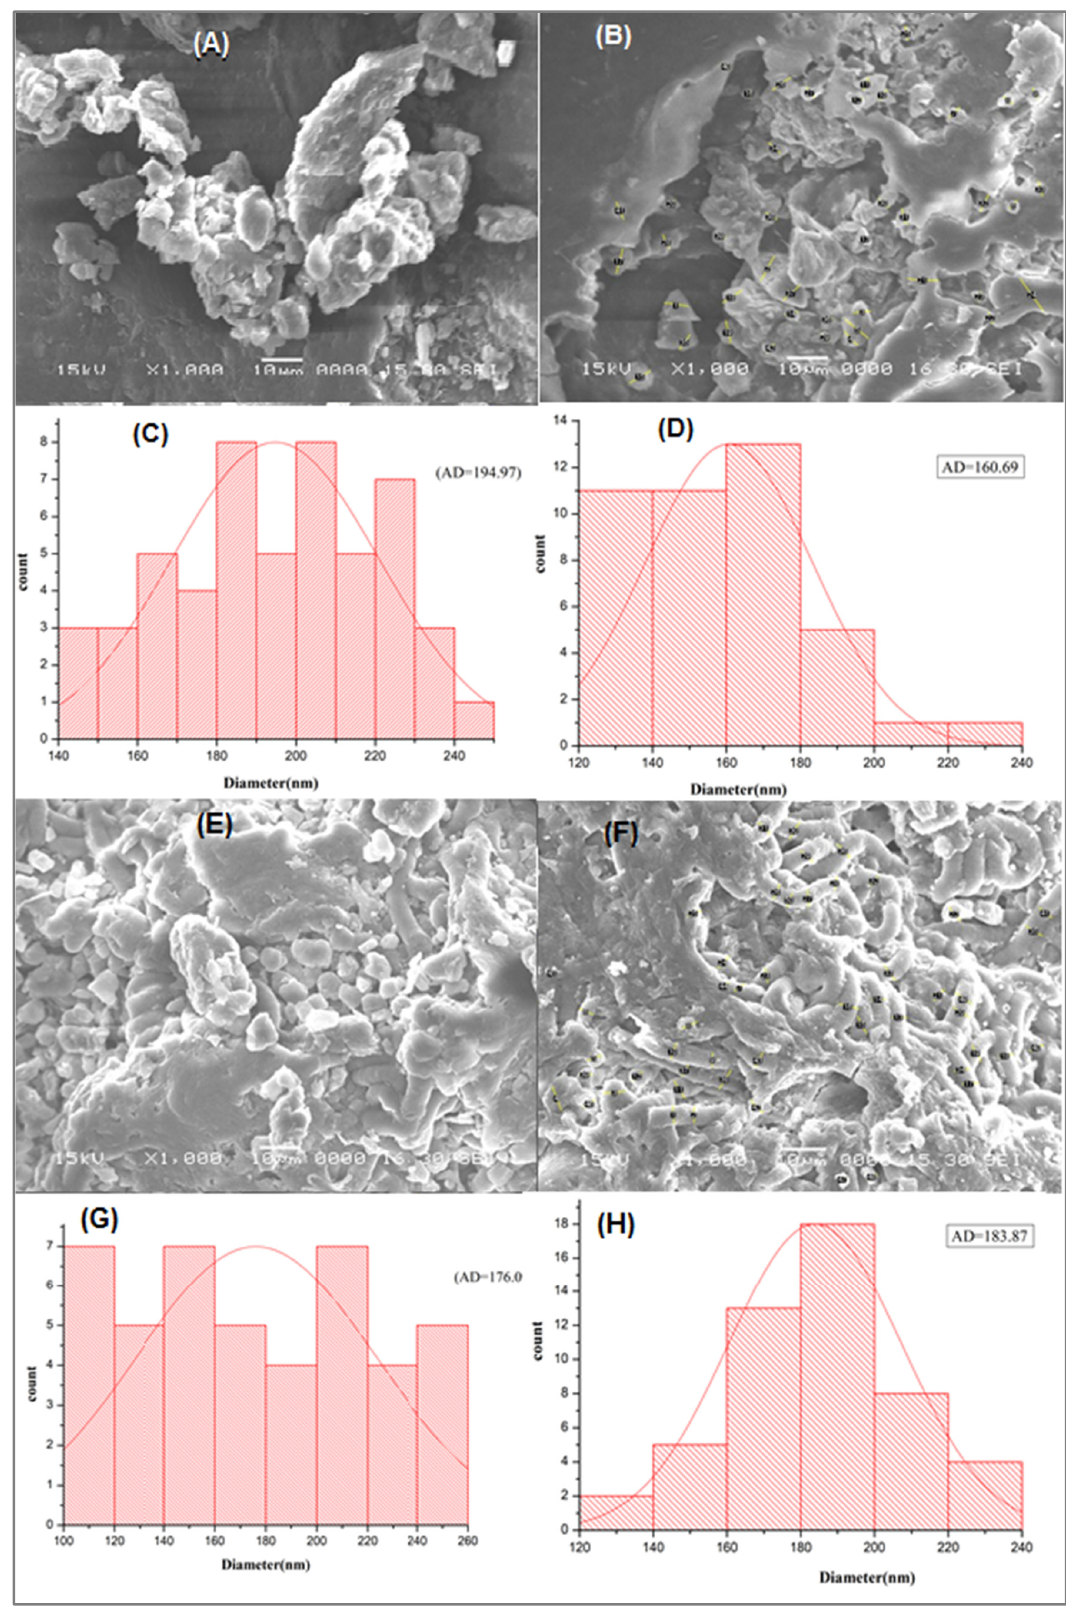
Figure 3. SEM pictures of ACDB before adsorption ( A ), after adsorption ( B ), and LFB before adsorption ( E ); LFB after adsorption ( F ), and the corresponding diameter distributions of ( C , D , G , and H , respectively).